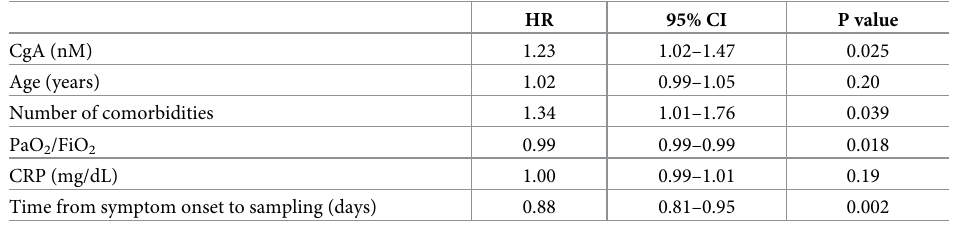
Table 2. Multivariable Cox regression analysis predicting